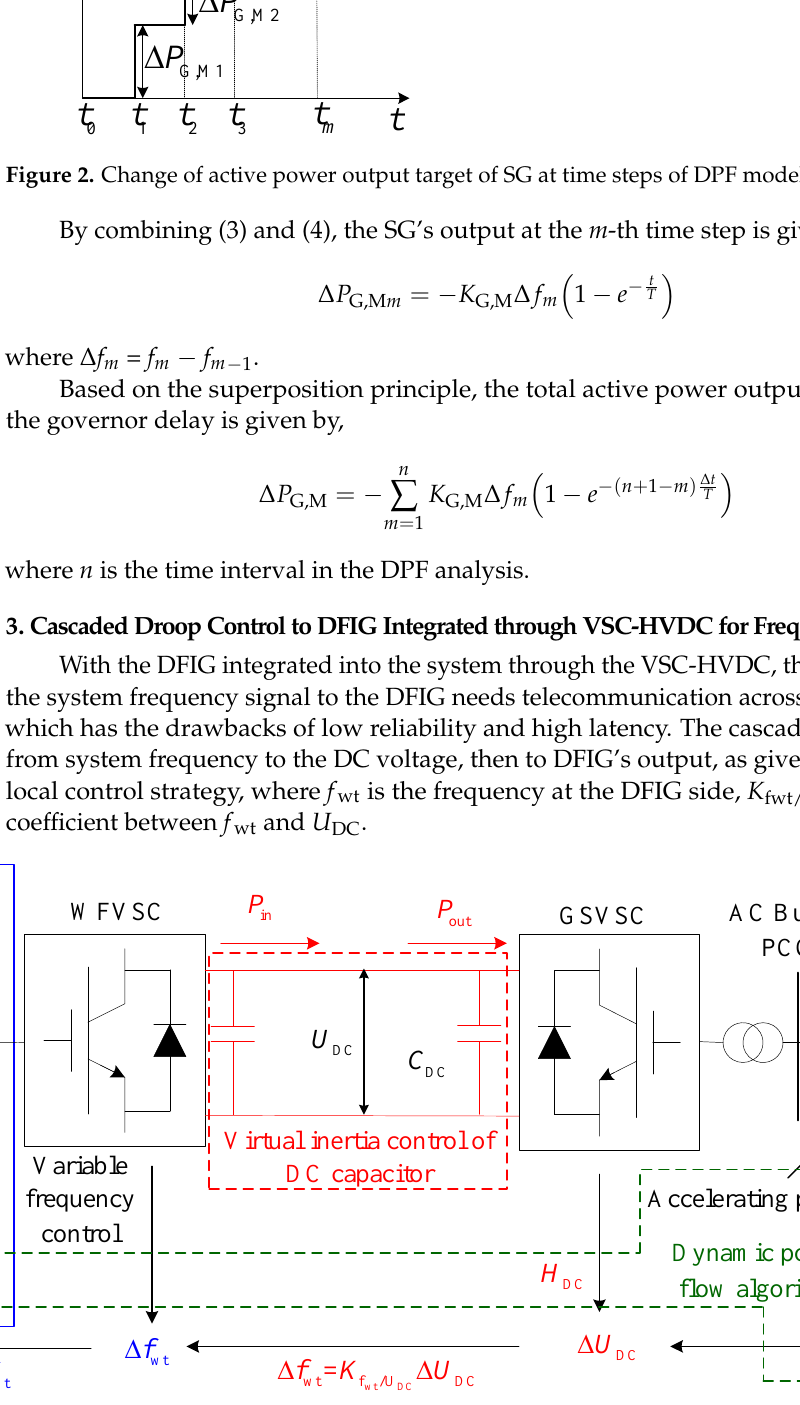
Figure 3. Frequency regulation by DFIG integrated through VSC-HVDC.